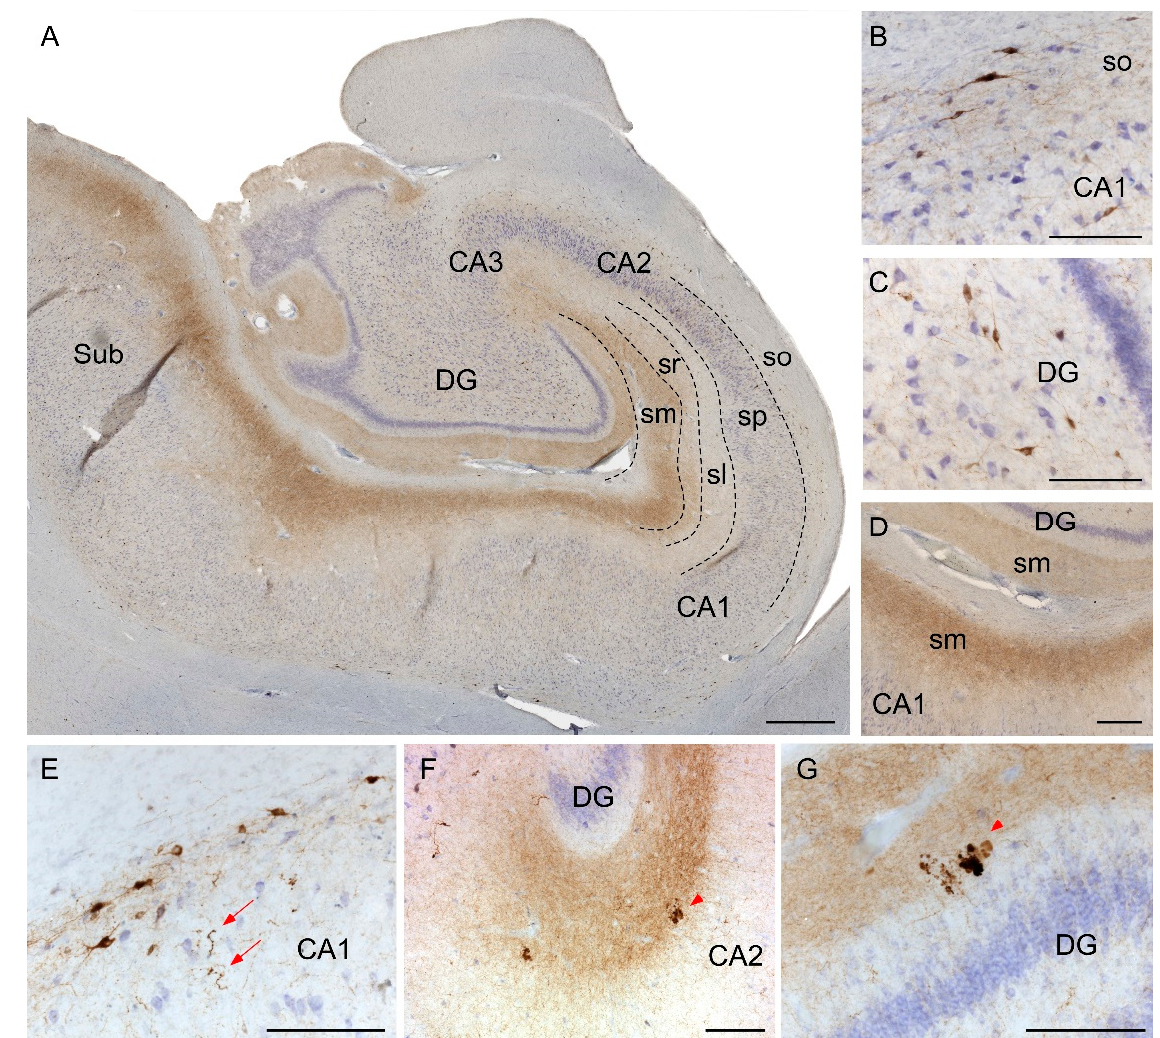
Figure 3. Immunohistochemistry staining of somatostatin in the hippocampus. Mosaic reconstruction of the non-AD human hippocampus showing somatostatin distribution ( A ). In non-AD cases, somatostatin-expressing cells were mainly located in either the stratum oriens in CA regions ( B ) or within the hilus in the DG ( C ) and somatostatin fibers were mainly localized to the molecular layers of CA-DG regions ( D ). The major hallmarks of somatostatin in AD brains were dystrophic neurites ( E ) and aggregates of fibers and cell debris mainly in the molecular layers of CA ( F ) and DG ( G ). CA, cornus amonis; DG, dentate gyrus; Sub, subiculum; so, stratum oriens; sp, stratum piramidale; sl, stratum lacunosum; sr, stratum radiatum; sm, stratum moleculare. Scale bar A , 500 µm; B – G , 160 µm.